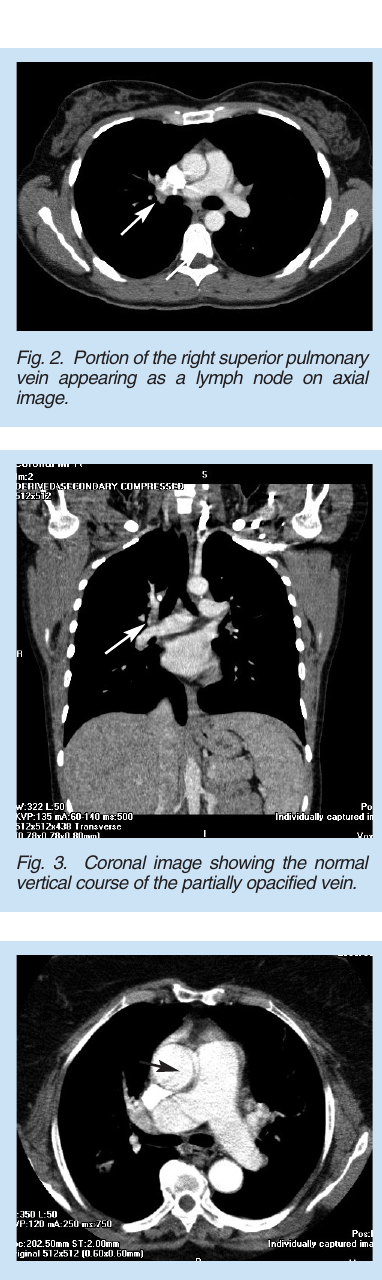
Fig. 4. Aortic pulsation imitating dissection in the ascending aorta.